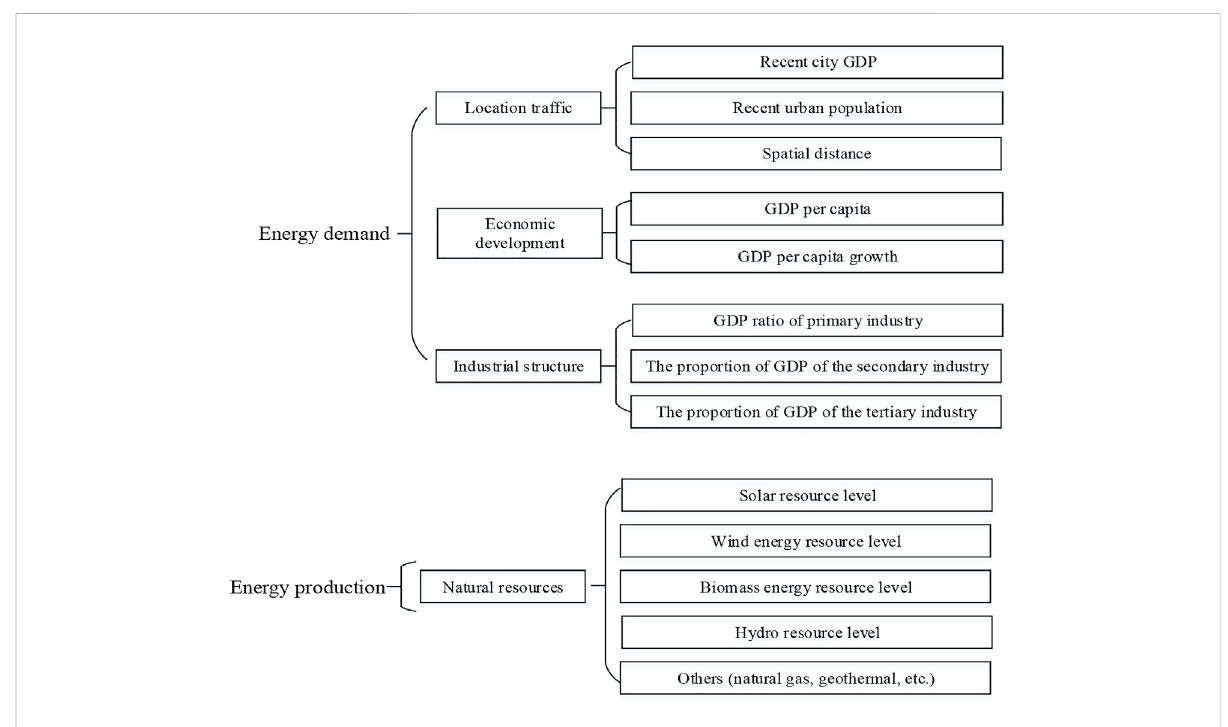
FIGURE 2 Classi fi cation index system of rural differentiated energy